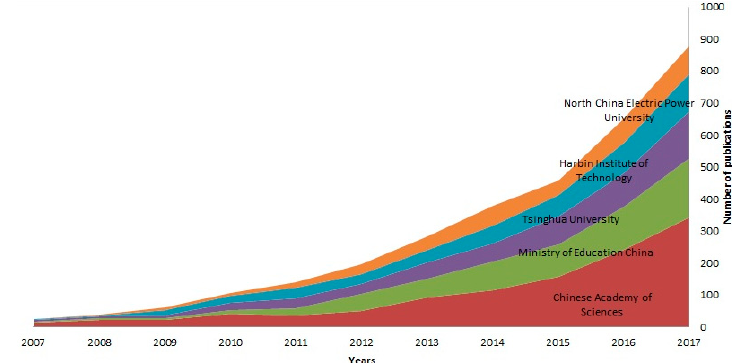
Figure 7. Time evolution of the top five productive institutions over the period 2007–2017.